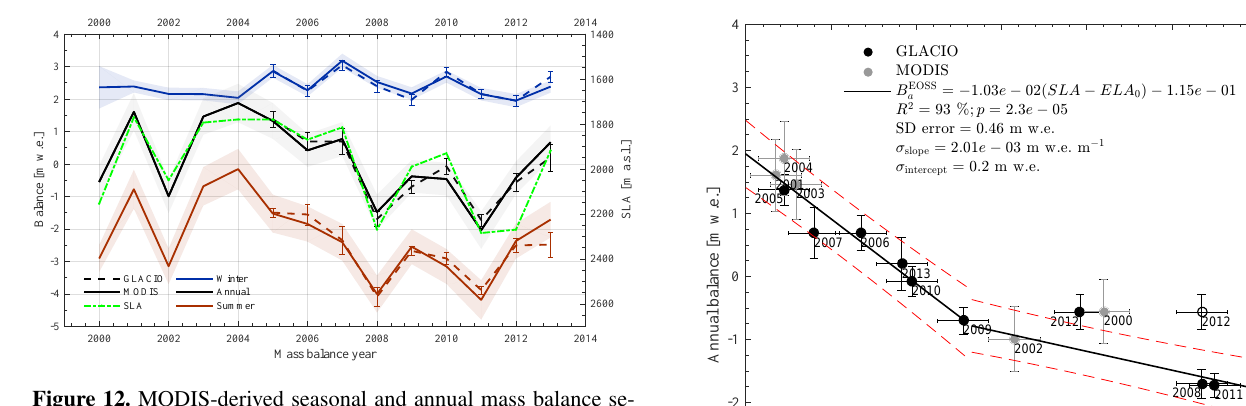
Figure 12. MODIS-derived seasonal and annual mass balance se- ries of Brewster Glacier (solid line) compared to estimations from glaciological observations (dotted line). Standard errors of predic- tion are shown in shaded envelopes. Note the record of end-of- summer snowline elevation (SLA) from the EOSS programme and its close match to the annual balance series.